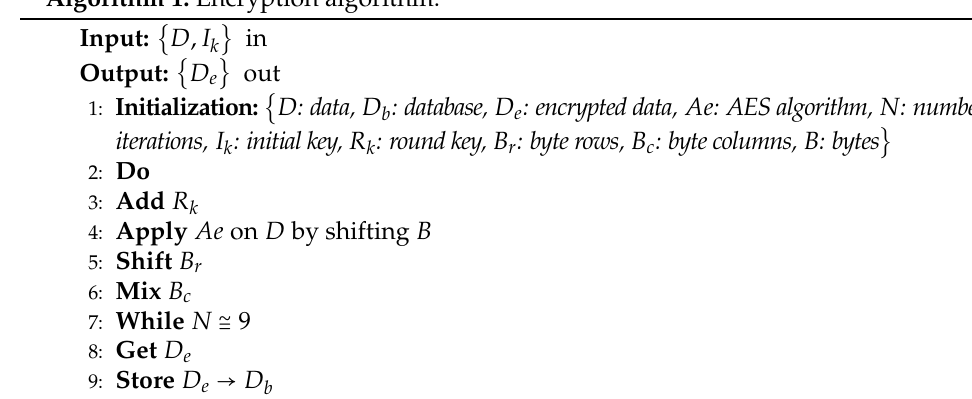
Algorithm 1: Encryption